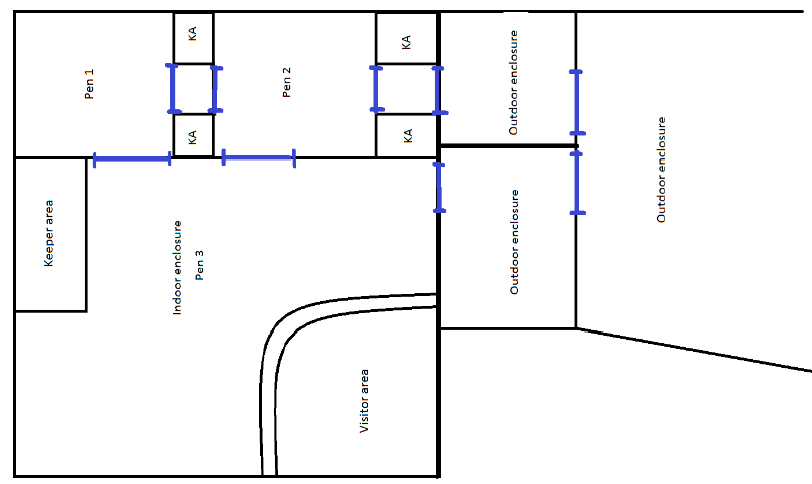
Figure 1. Diagram of giraffe enclosure. Blue lines indicate animal gates operated by keeper staff. All video clips were recorded from the visitor area. KA = keeper area.